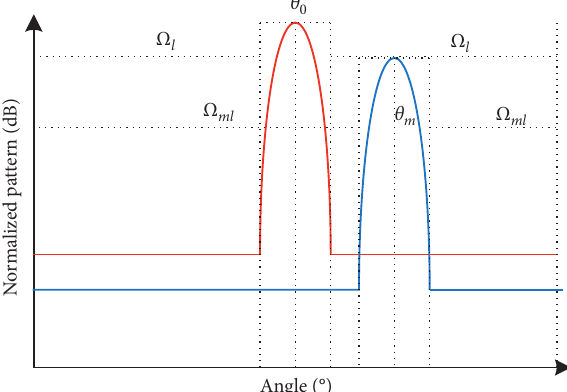
Figure 3: Constraint pattern.